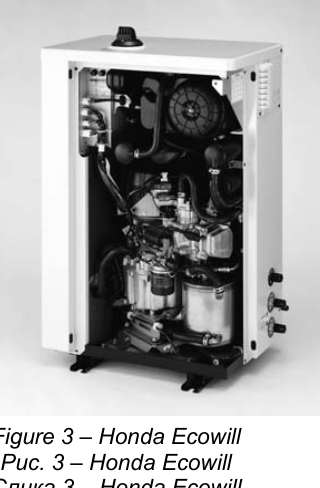
Figure 3 – Honda Ecowill Рис . 3 – Honda Ecowill Слика 3 – Honda